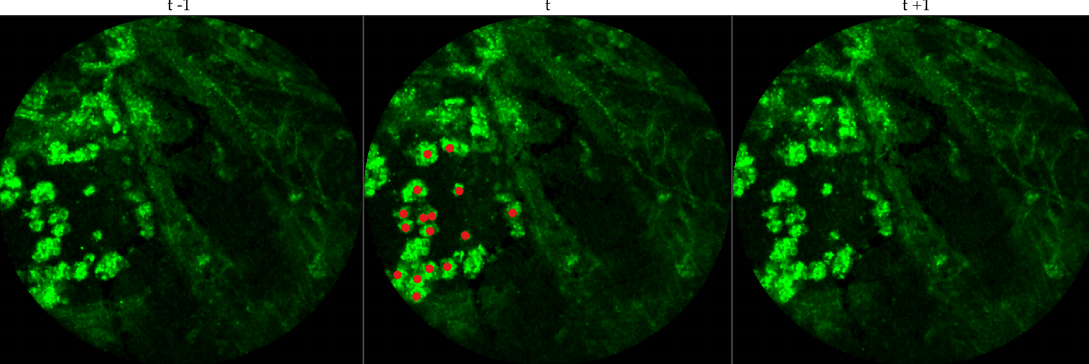
Figure 4. FCFM image frame with annotated cells shown as dots at time t